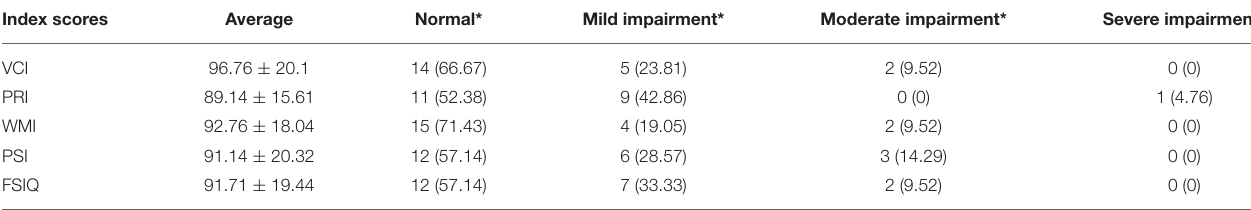
TABLE 2 | Distribution of index scores.